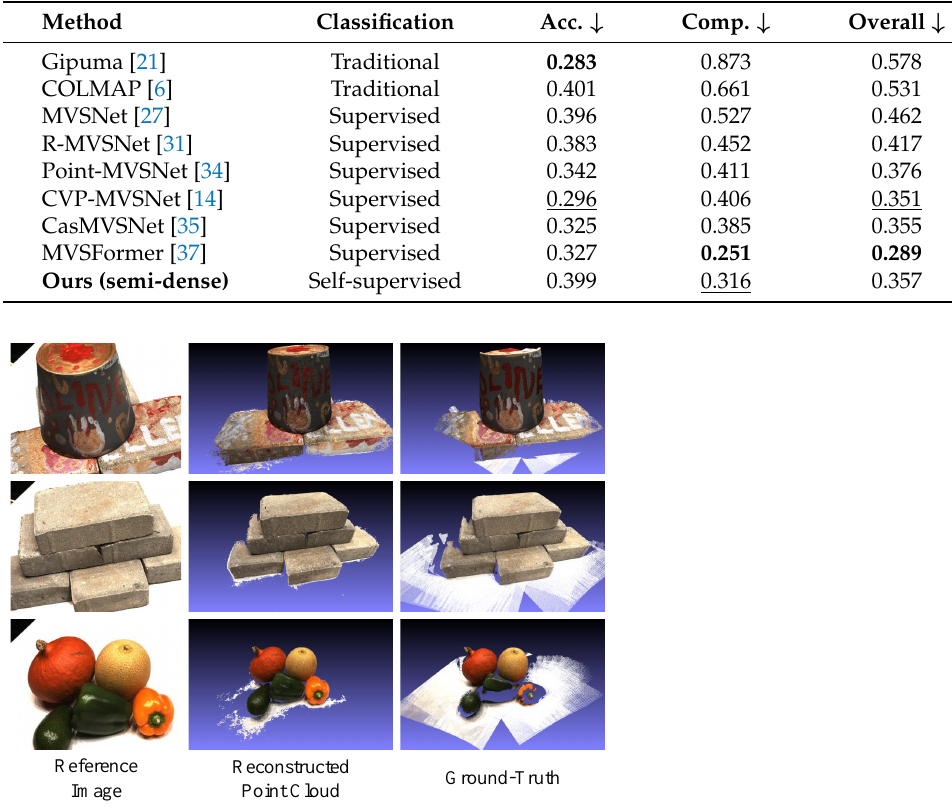
Figure 7. Qualitative results of our approach on the DTU dataset in terms of reconstructed point